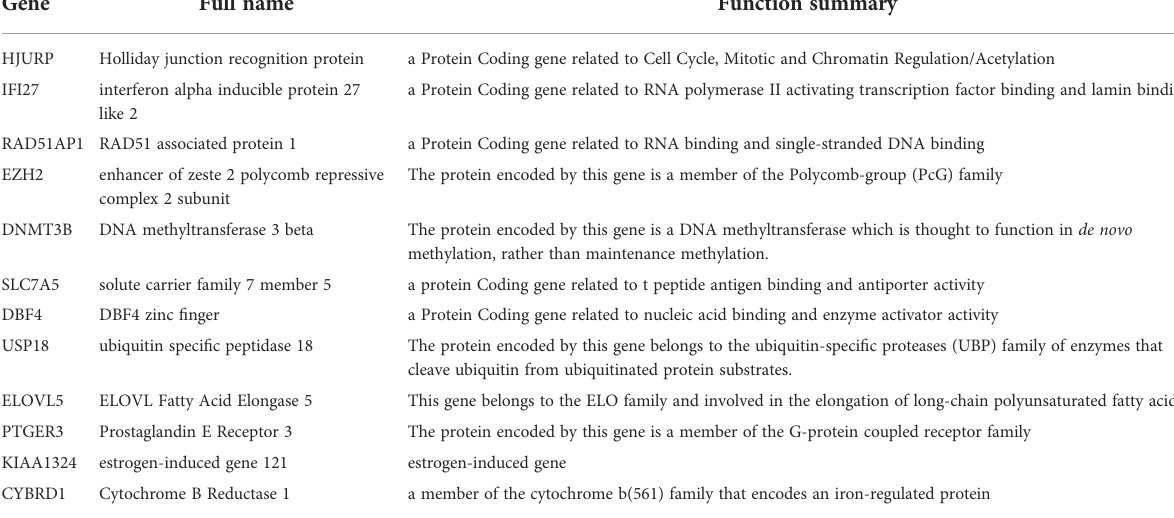
TABLE 2 The function of the twelve